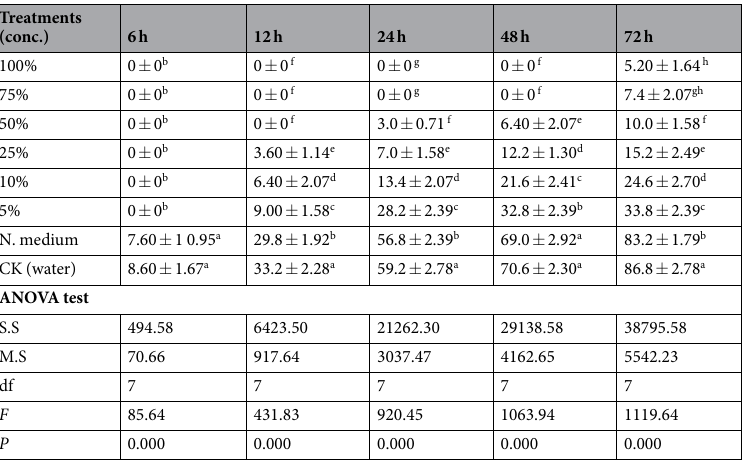
Table 1. Effect of Snef1216 on eggs hatching of M. incognita . Data presents the mean ± standard deviation. The same letter within columns are significantly similar according to Duncan’s multiple range test ( P > 0.05). Whereas; S.S (Sum of square); M.S (Mean square); df (Degree of freedom); F (F-value); P (significant